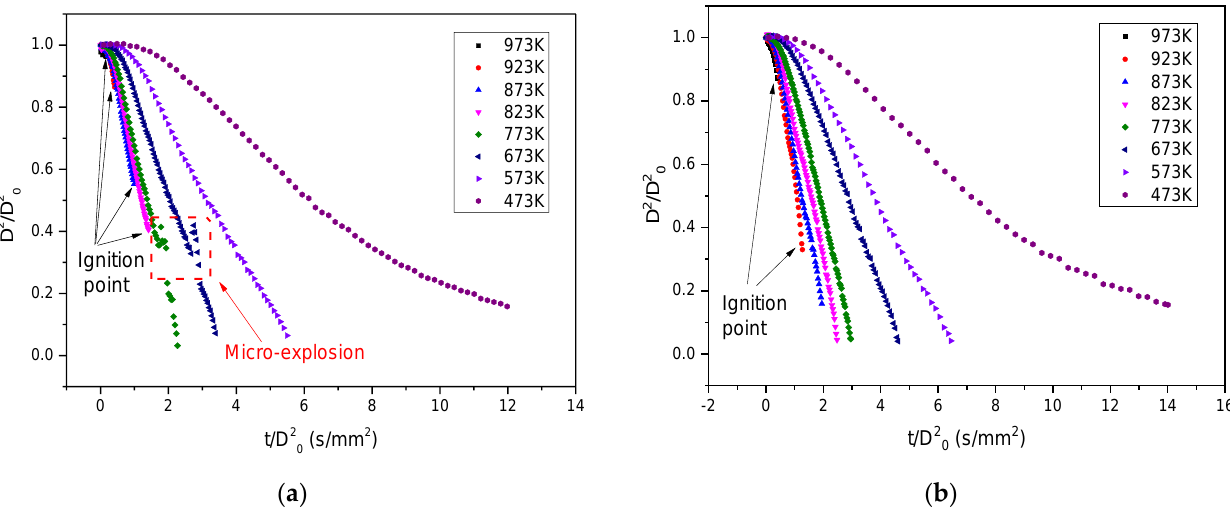
Figure 3. Temporal variation of the normalized D 2 under vary temperatures: ( a ) 1.0 bar; ( b ) 0.4 bar.